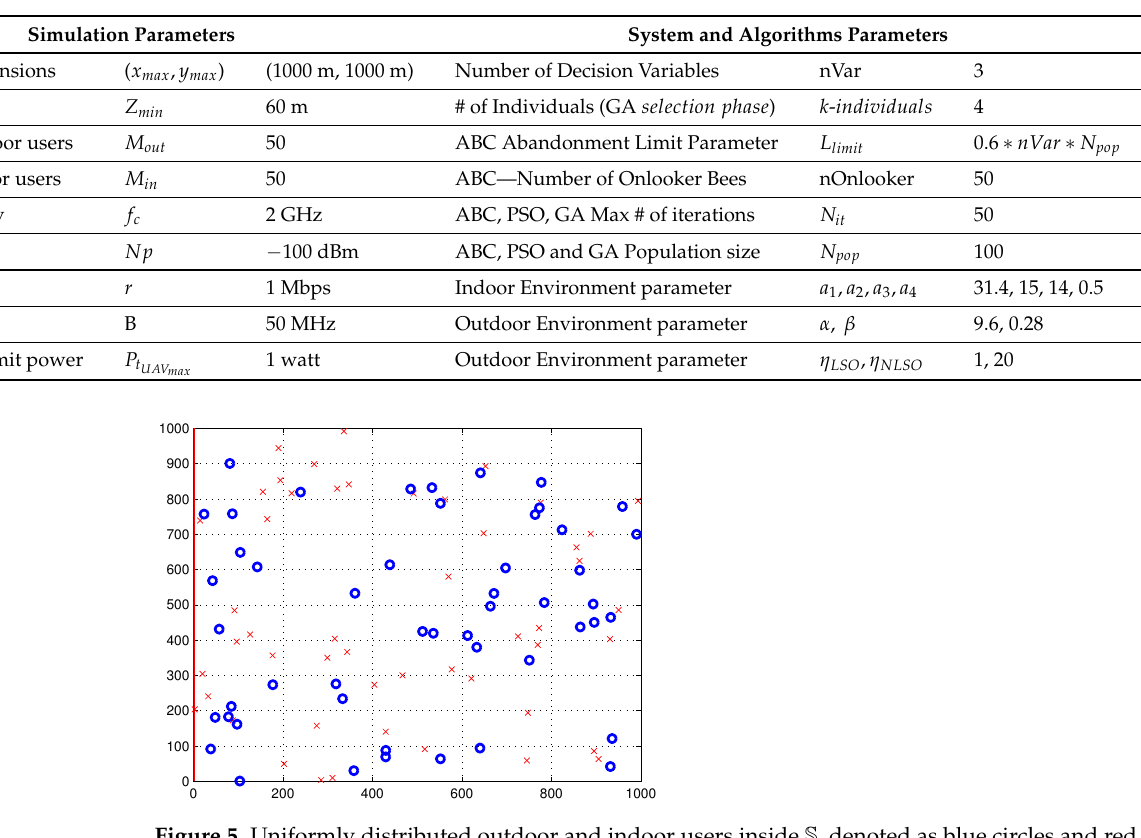
Table 2. Simulation and system parameters.